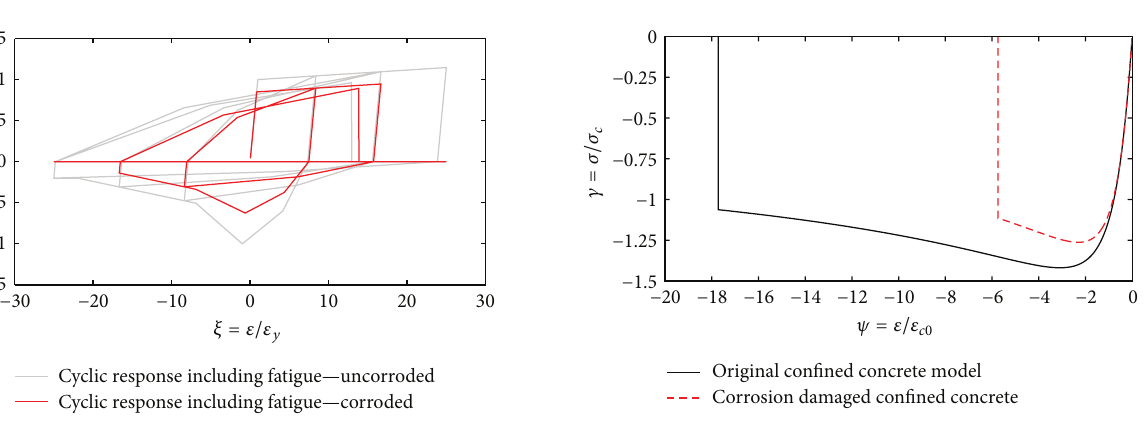
Figure 5: Cyclic response of the Hysteretic + Fatigue model in OpenSees (20% mass loss).